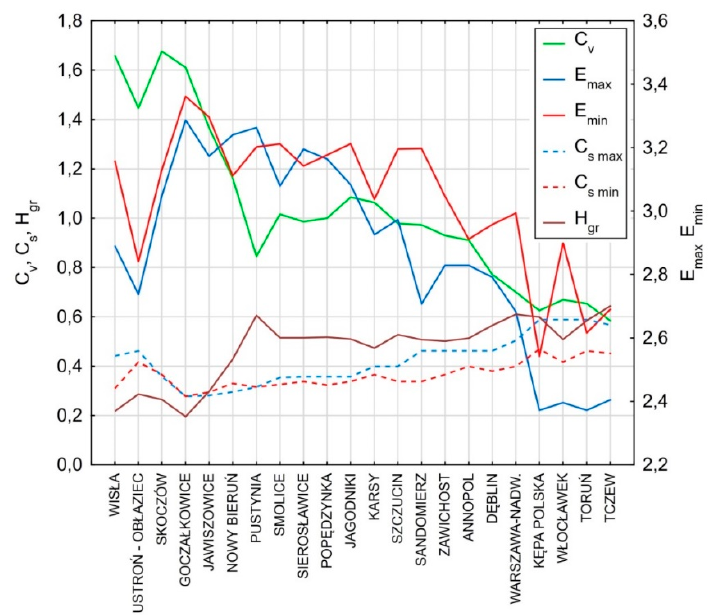
Figure 3. Characteristics of the flow regime along the course of the Vistula River mainstream. C V —variability of daily discharges, C S —coefficient of stability of the maximum and minimum monthly flows, H gr —coefficient of groundwater supply, E max —entropy of the maximum monthly flows, E max —entropy of the minimum monthly flows.